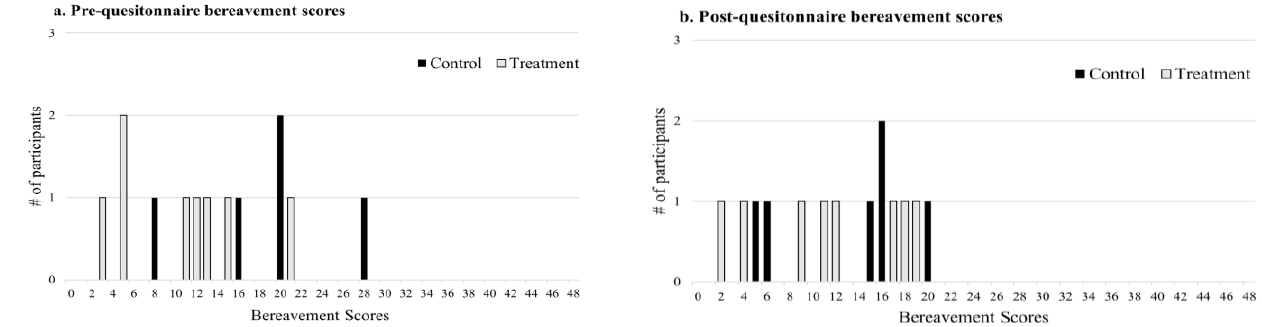
Figure 2. ( a , b ) Frequency of overall bereavement scores from pre- and post-questionnaires of the non-treatment ( n = 6) and treatment groups ( n = 8).